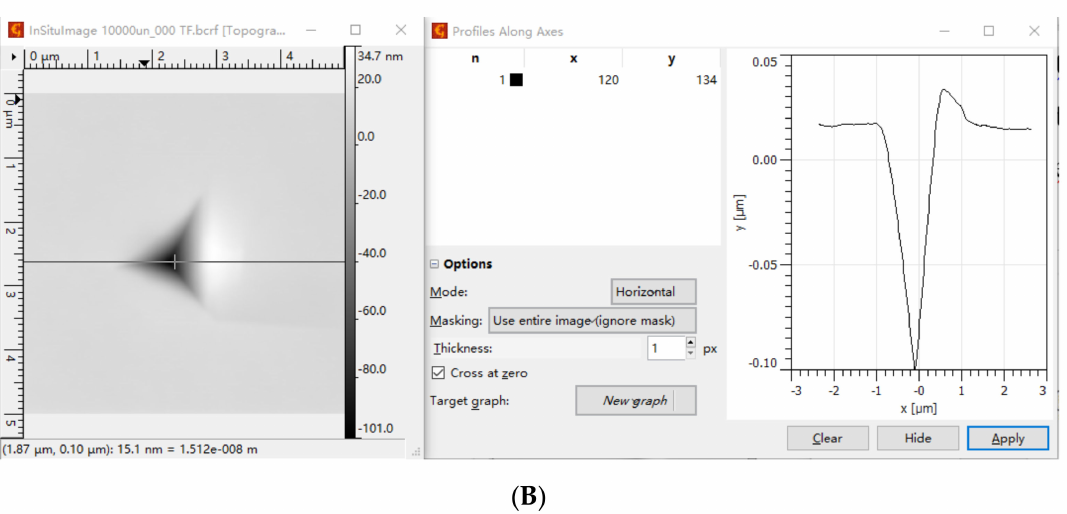
Figure 7. Indentation depths with 8mN and 10mN loads. ( A ) 8 mN Load Indentation Depth; ( B ) 10 mN Load Indentation Depth.